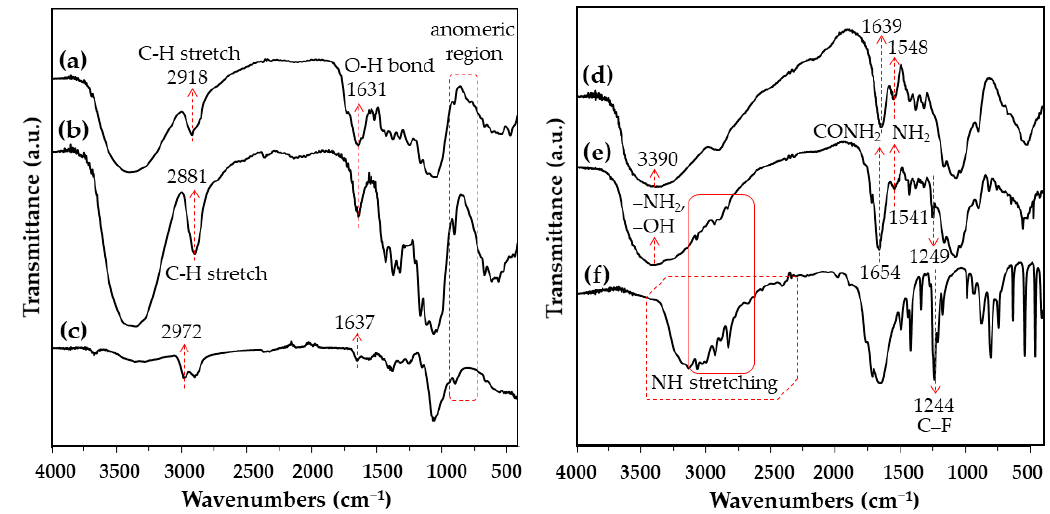
Figure 5. FTIR of ( a ) rice straw waste, ( b ) CF, ( c ) CS NPs, ( d ) CS-CF BNCs, ( e ) CS-CF/5FU BNCs and ( f ) 5FU.